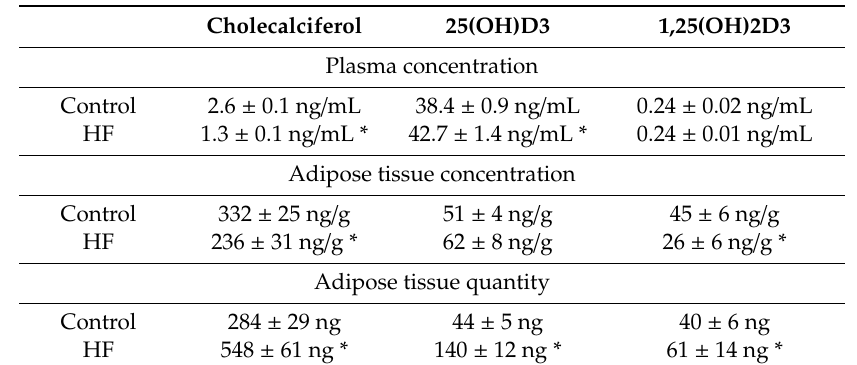
Table 4. Concentrations and quantities of the three Amplifex-derivatized vitamin D 3 metabolites in mouse plasma and adipose tissue after 11 weeks of diet. The quantities in adipose tissue were calculated as concentration x mass of epididymal white adipose tissue